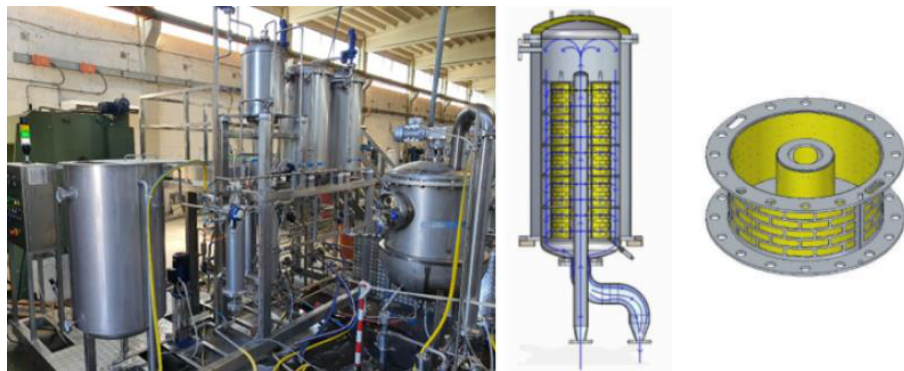
Figure 7. Pressure-resistant reactors for SWE (C2FUT Srl.). Left: plant photo; right: reactor tank and loading vessel scheme, DSTF — University of Turin.